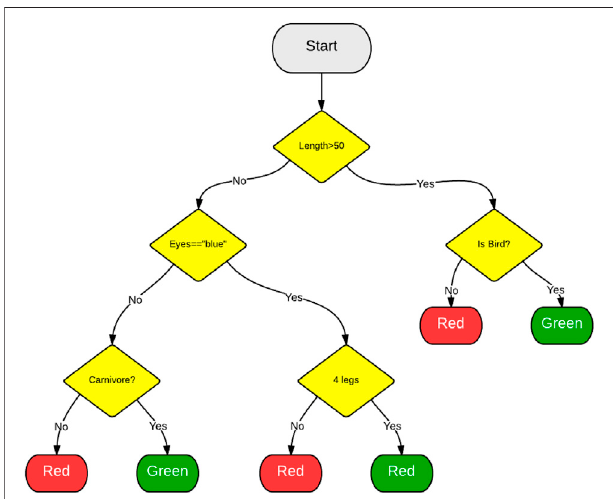
FIGURE 2 | General logical characteristics of a decision